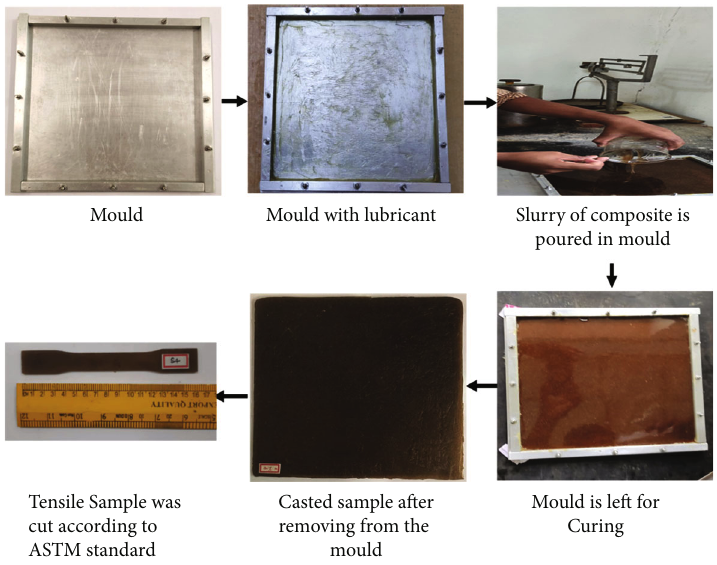
Mould is left for Casted sample after Curing removing from the mould Figure 2: Composite fabrication fl owchart.